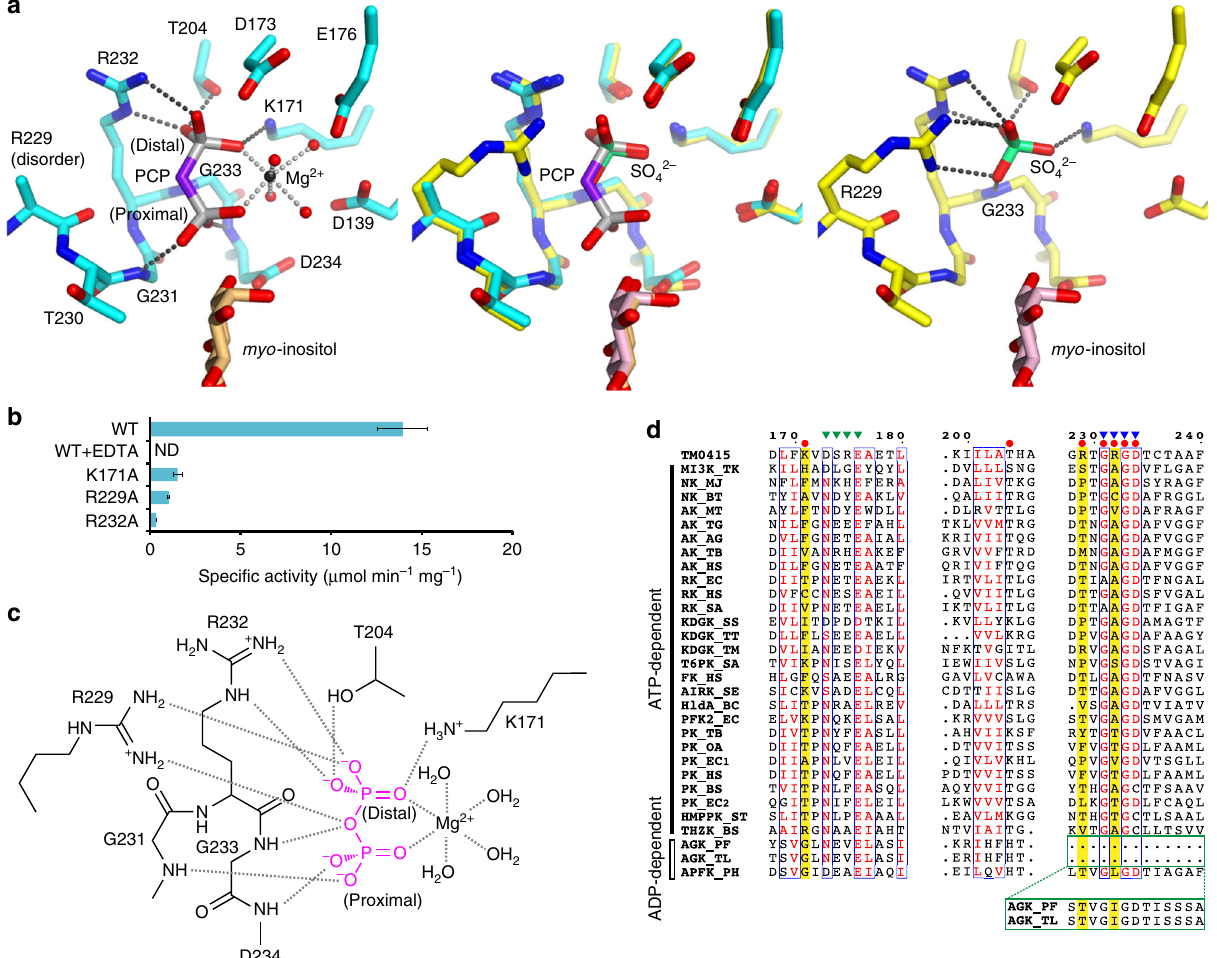
Fig. 3 PPi recognition in TM0415. a The PPi-binding sites of the PCP complex (left, cyan) and the SO 4 2 – complex (right, yellow) of TM0415. Superposition of the two complexes is shown in a center panel. Dotted lines represent the interactions involving PCP, the sulfate ion, and the magnesium ion. The three panels are drawn from the same viewpoint. b Speci fi c activities of TM0415 (wild-type and its mutants). WT, wild-type; WT + EDTA, wild-type in the presence of 1 mM EDTA. ND means no detectable activity. Activity measurements were performed in triplicate, and standard deviations are represented as error bars. c A schematic diagram depicting the probable PPi-recognition mode. Gray dotted lines show the interactions involving PPi (magenta) and the magnesium ion. d Sequence alignment of the ribokinase family enzymes based on 3D-structure superpositions. The sequences around the GXGD motif in AGK_PF and AGK_TL are displayed in a green box under the alignment, because the order of the secondary structures around the GXGD motif in the two AGKs is different from those in the other enzymes, although the regions around the motif are superimposable in 3D-structure. Details are explained in Supplementary Fig. 7. Red circles indicate the residues interacting with PPi in panel c . Yellow bars highlight the characteristic residues of TM0415 (K171, R229, and R232) and the corresponding residues. Green and blue triangles indicate the NXXE motif and GXGD motif, respectively. Abbreviations of